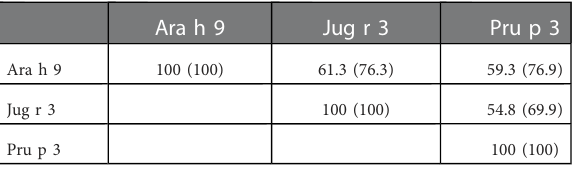
TABLE 7 Non-speci fi c LTP sequence identity and similarity.